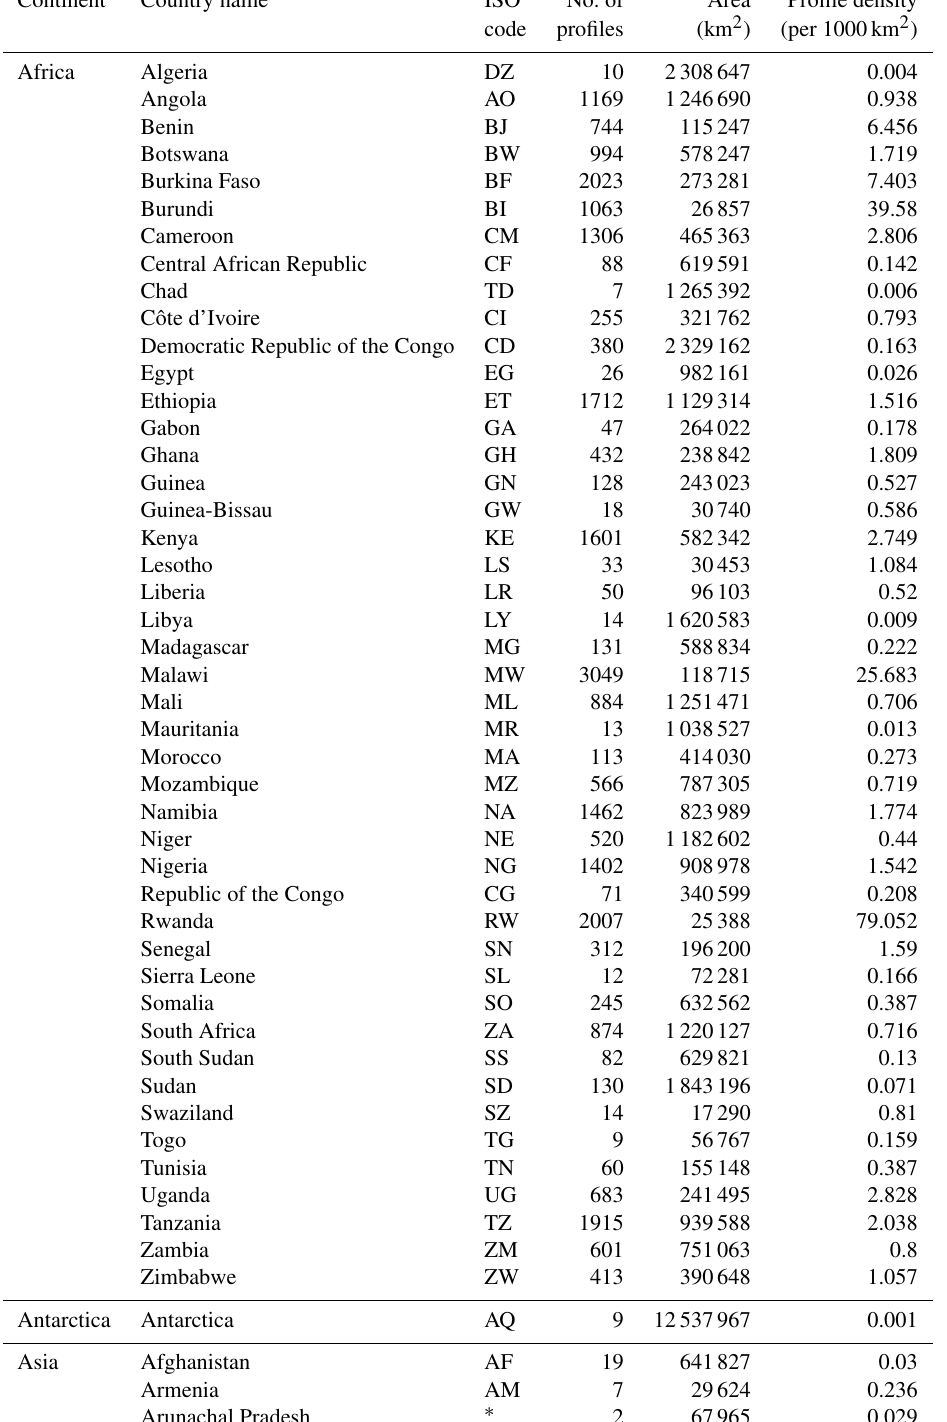
Table C1. Number of profiles by country and